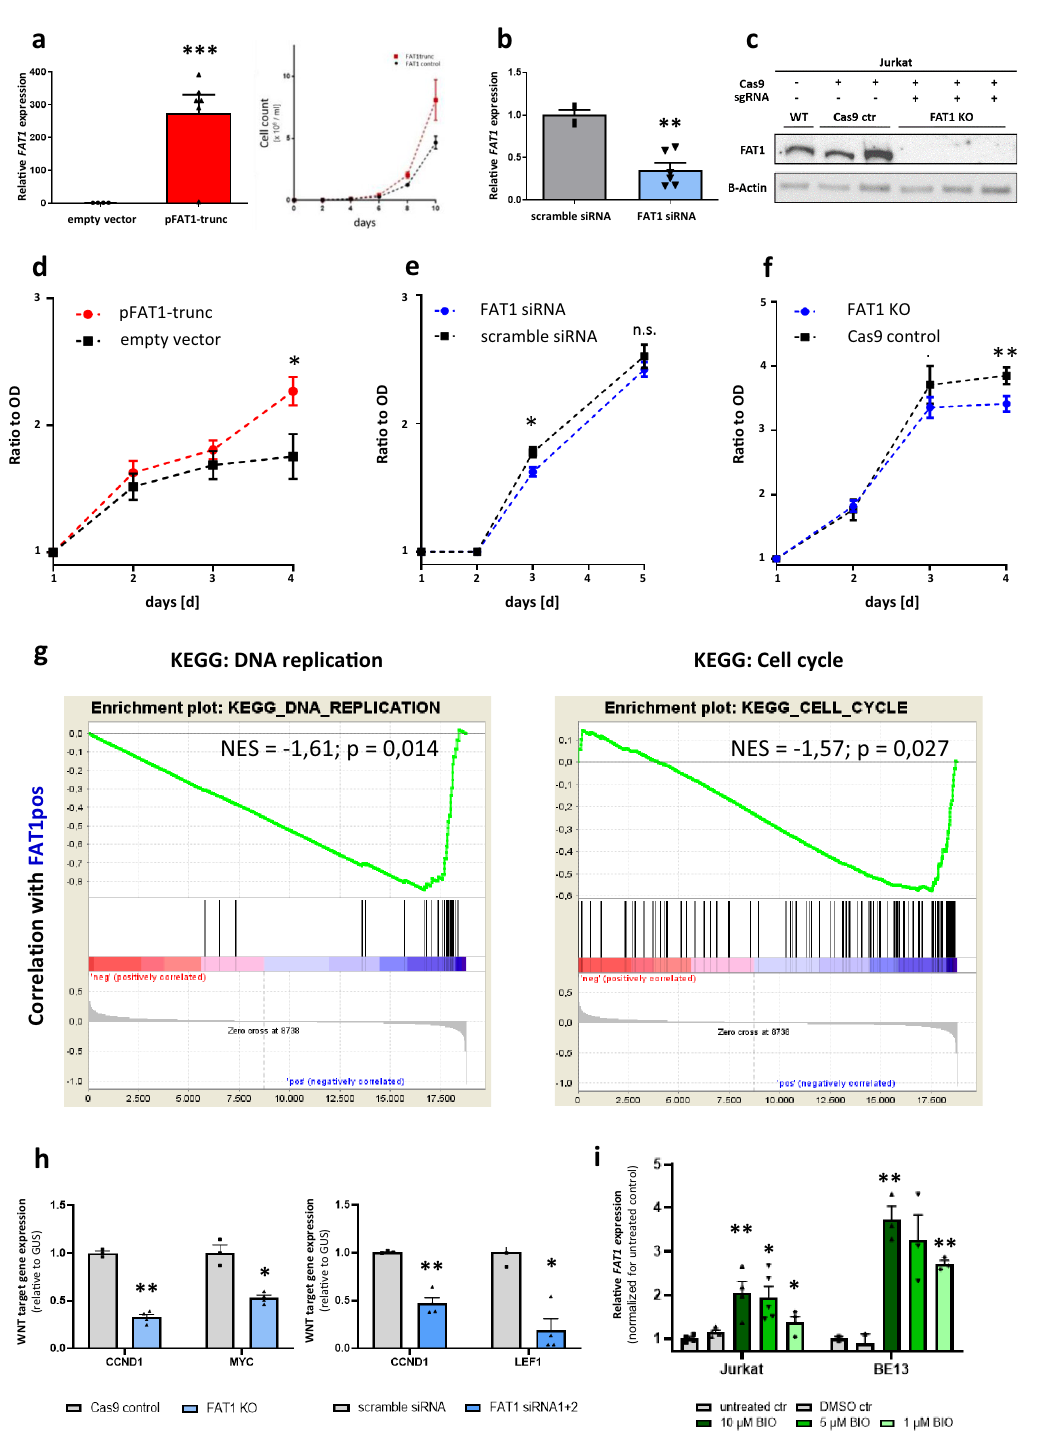
Figure 4. FAT1 induces proliferation in T-ALL and interacts with WNT signaling ( a ) FAT1 overexpression (OE) using a truncated FAT1 plasmid (pFAT1-trunc) in Jurkat demonstrated by RT-PCR (basic and transgenic expression). FAT1 overexpression led also to higher cell proliferation. Cells were counted every second day using a conventional trypan-blue staining comparing FAT1trunc and FAT1 control cells. ( b ) Specific siRNA FAT1 KD in Jurkat with two independent siRNAs assessed by RT-PCR. ( c ) CRISPR/Cas9- mediated FAT1 Knockout (KO) in T-ALL cell line Jurkat validated by Western blot analysis (full-length gel provided as supplementary information file). ( d – f ) WST-1 proliferation assay after ( d ) FAT1 OE, ( e ) KD or ( f ) KO proofed a proliferative advantage of high FAT1 expression in Jurkat as a T-ALL model. Data plotted as ratio to optical density (OD) after normalization at days [d] 1, 2, 3 and 4 or 5. ( g ) GSEA for KEGG DNA REPLICATION and KEGG CELL CYCLE were performed analyzing all FAT1pos and FAT1neg T-ALL samples from the patient cohort. ( h ) Representative results showing downregulation of WNT target genes, namely CCND1 , LEF1 and MYC due to FAT1 KO (CCND1: FC = −3.0, p = 0.002; MYC: FC = −1.86, p = 0.026) or FAT1 KD (CCND1: FC = −2.13, p = 0.004; LEF1: FC = −5.26, p = 0.016) as analyzed by RT-PCR. ( i ) Dose-dependent upregulation of FAT1 expression caused by treatment with WNT pathway activator BIO in the T-ALL cell line Jurkat and BE13 underlines FAT1-WNT pathway interaction (n.s.: not significant; *p < 0.05; **p <